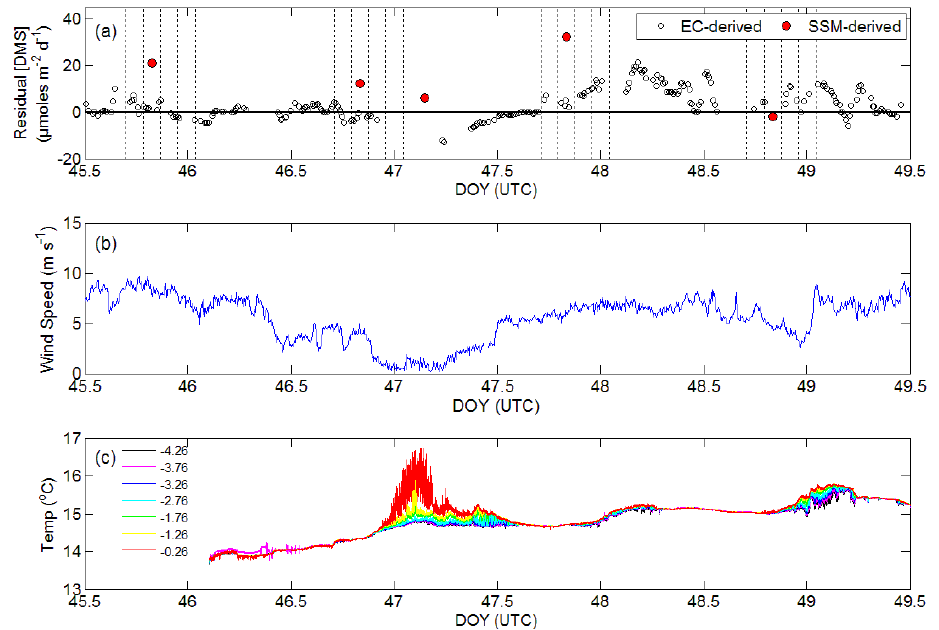
Figure 7. The period between DOY 45.5 and 49.5 in Bloom 1 showing (a) SSM-derived residual [DMS] (solid red circles) and EC-derived [DMS] (open black circles). SSM measurements for DOY 47.1 coincided with a gap in EC air–sea flux data. Vertical dashed lines indicate the period from 3h before to 5h after sampling (not shown for DOY 47.1). (b) Wind speed normalized to 10m. (c) Near-surface temperatures (legend shows depth in